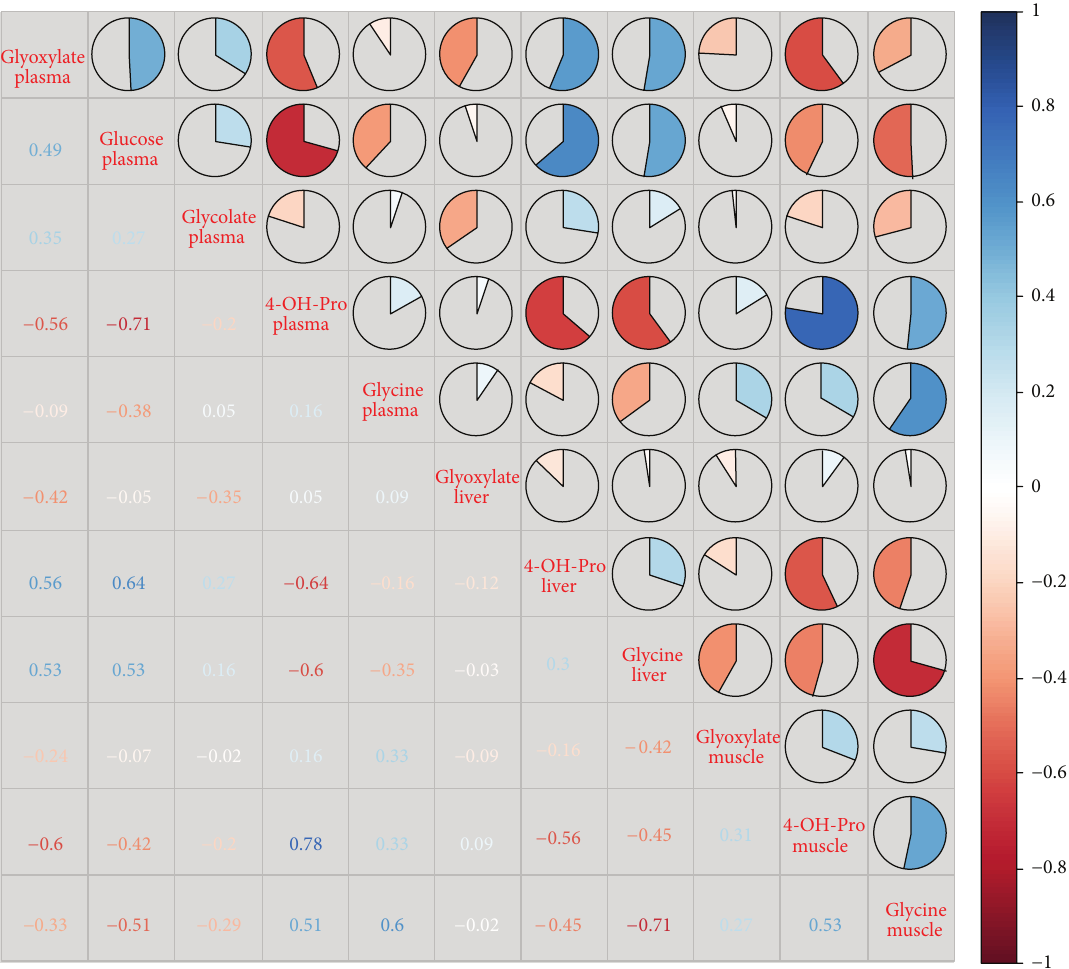
Figure1:Correlationmatrixwithglyoxylateandprecursors/productsofglyoxylatemetabolism.Kendall’staucorrelationsbetweenmetabolite levelsofglyoxylate,glycineand4-hydroxyprolineinliver(L),muscle(M),andplasma(P)andofglycolateinplasmaarevisualized.Blueshades represent positive correlations and red shades represent negative correlations. The more the circle is filled, the higher the absolute correlation